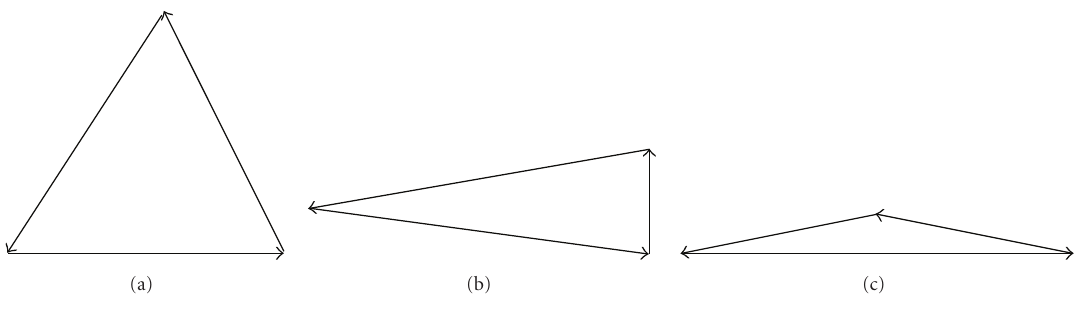
Figure 2: Momentum configurations: (a) equilateral, (b) squeezed, and (c)